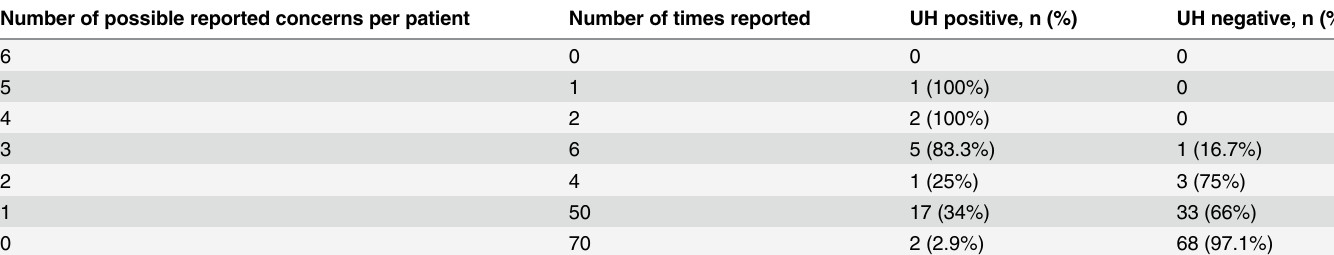
Table 6. Correlation between the number of concerns and unintended hospitalizations (P < 0.001). Number of possible reported concerns per patient